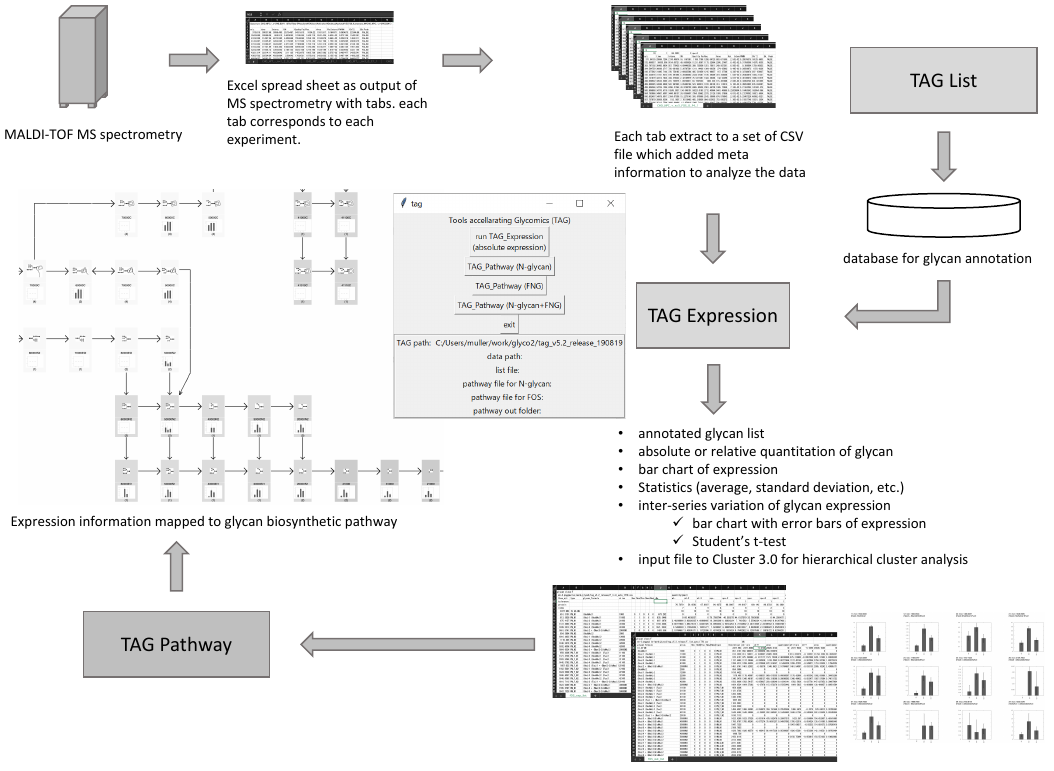
Figure 1. Overview of Toolbox Accelerating Glycomics (TAG). Table 1. Functions of Toolbox Accelerating Glycomics